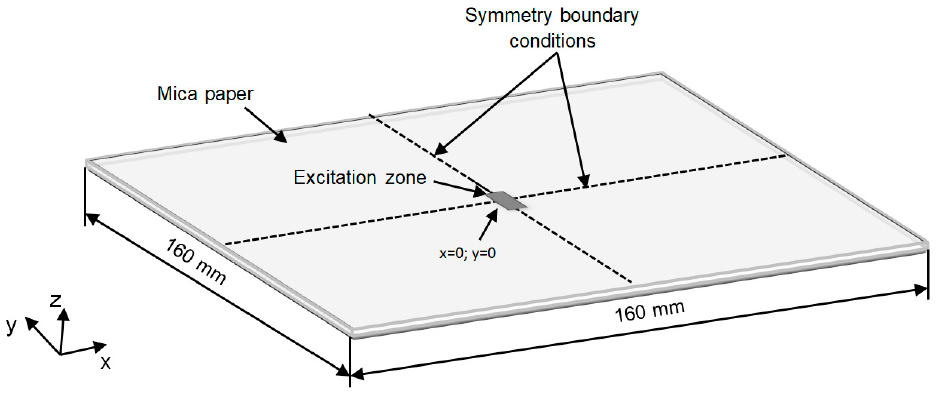
Figure 1. A model of the mica sample used for the simulation.